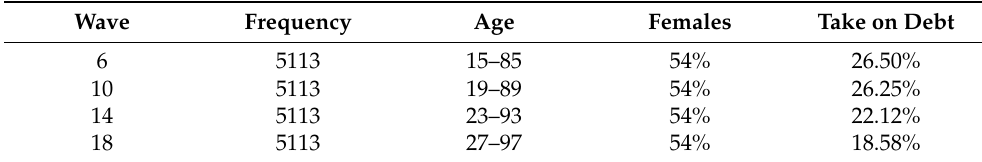
Table 3. Summary statistics of the balanced